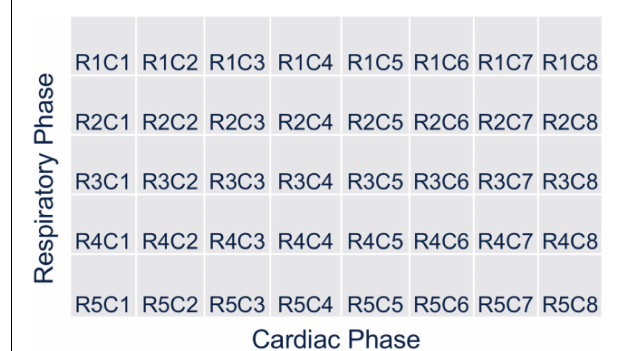
FIGURE 7 | Gating scheme for the reconstruction: There are 8 cardiac and 5 respiratory gates corresponding to 40 gates for each 4D XCAT phantom